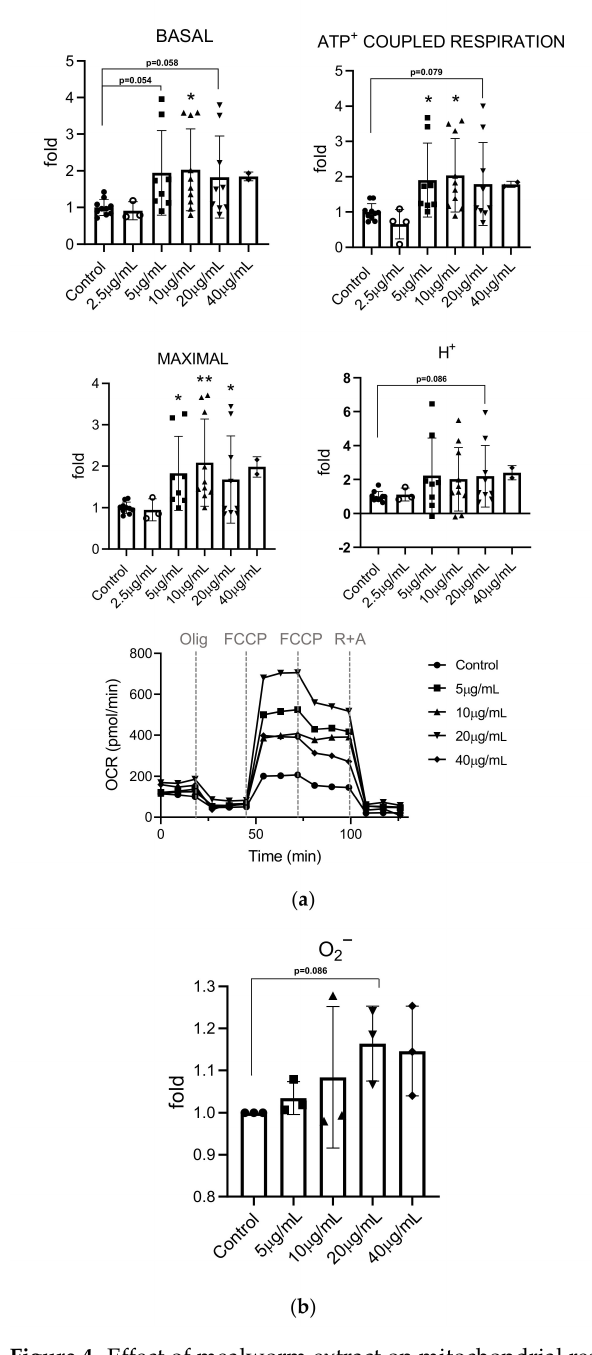
Figure 4. Effect of mealworm extract on mitochondrial respiration and mitochondrial superoxide production. ( a ) Confluent BAEC cultures were incubated with the indicated amounts of extract for 24 h. Mitochondrial respiration was determined using a Seahorse XF24 analyzer (Agilent). Oxygen consumption rates (OCRs) were used to determine basal respiration, maximal respiratory capacity, ATP + coupled respiration, H + -leak (upper panels). A representative experiment showing the real- time changes in OCR of BAECs treated with the indicated amounts of extract for 24 h prior to the addition of oligomycin (Olig) (6 µ M), FCCP (0.150 µ M) and rotenone/antimycin A (R + A) (0.05 µ M each) at the indicated times (bottom panel). The bottom panel shows a representative experiment; ( b ) confluent BAEC cultures were incubated with the indicated amounts of extract for 24 h and labelled with MitoSOX to determine mitochondrial superoxide (O 2 − ) production. The graph shows mean values ± SD. n=3 independent experiments. Each data point is the average value of two technical replicates. p < 0.05 (*) p < 0.01 (**), versus Control, according to one-way